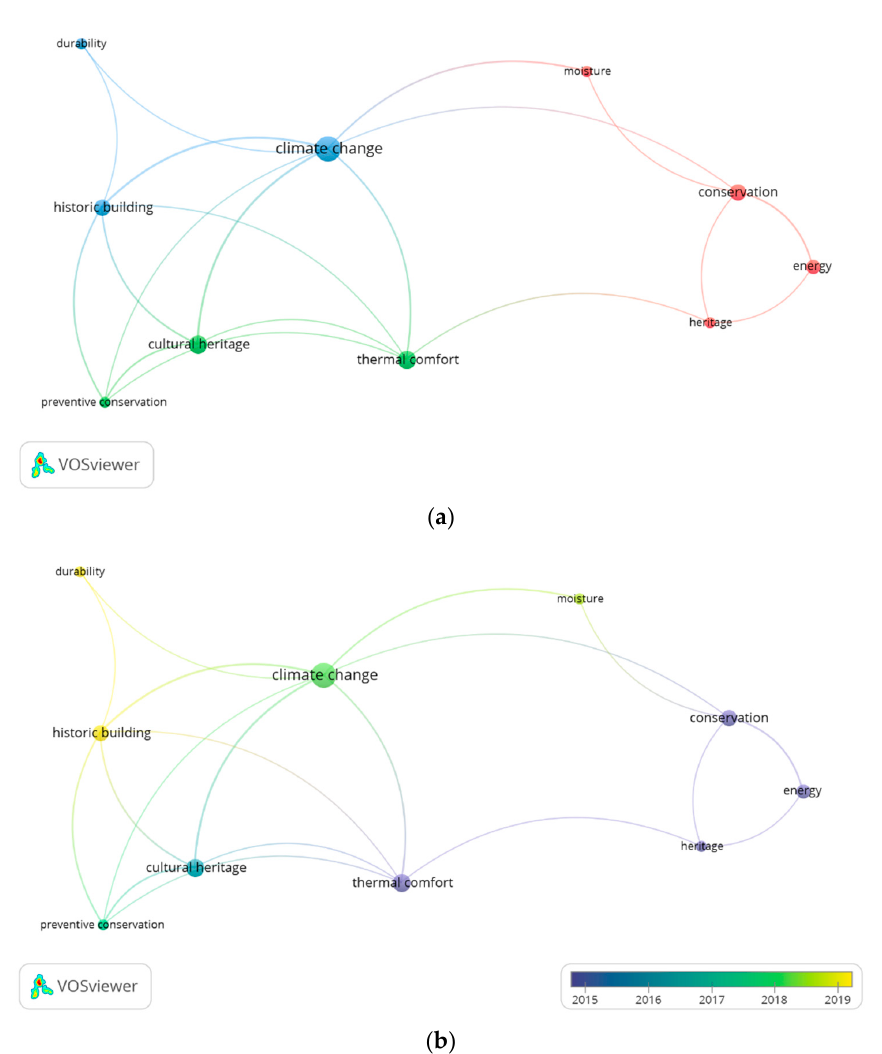
Figure 8. Author keywords co-occurrence analysis: ( a ) network visualization; ( b ) overlay visualization. Table 3. Top-five authors’ keywords with the highest number of occurrences (and link strength).